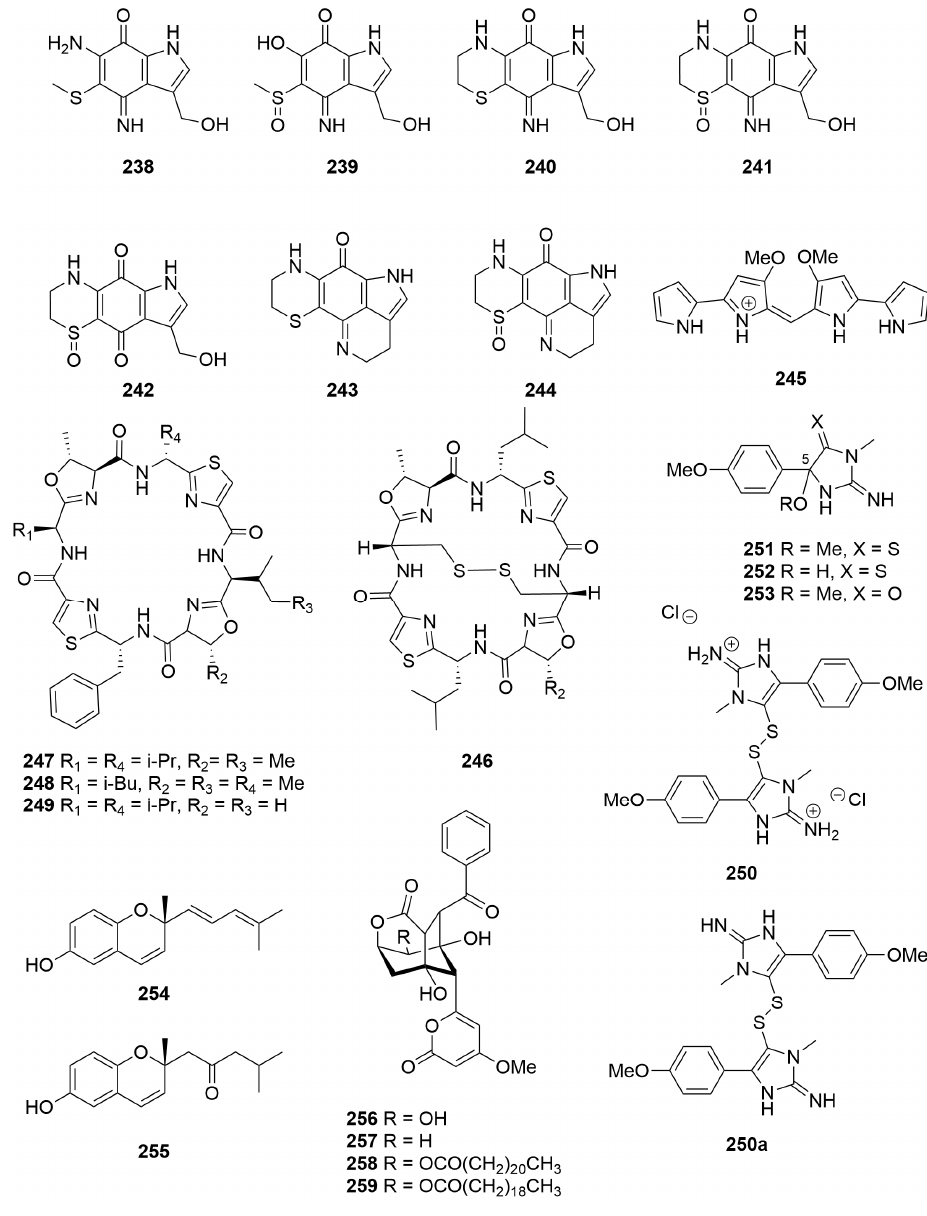
Figure 16. Compounds 238 to 259 .